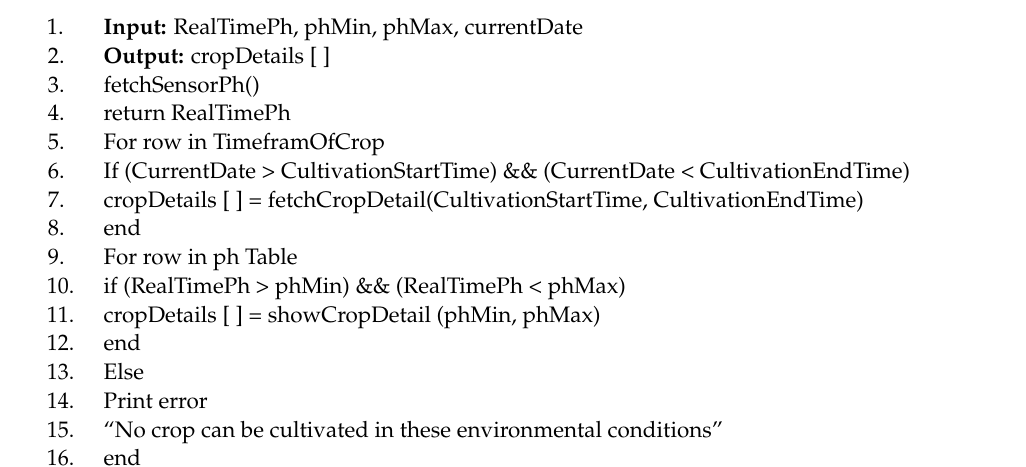
Algorithm 1 : A Fuzzy Logic System